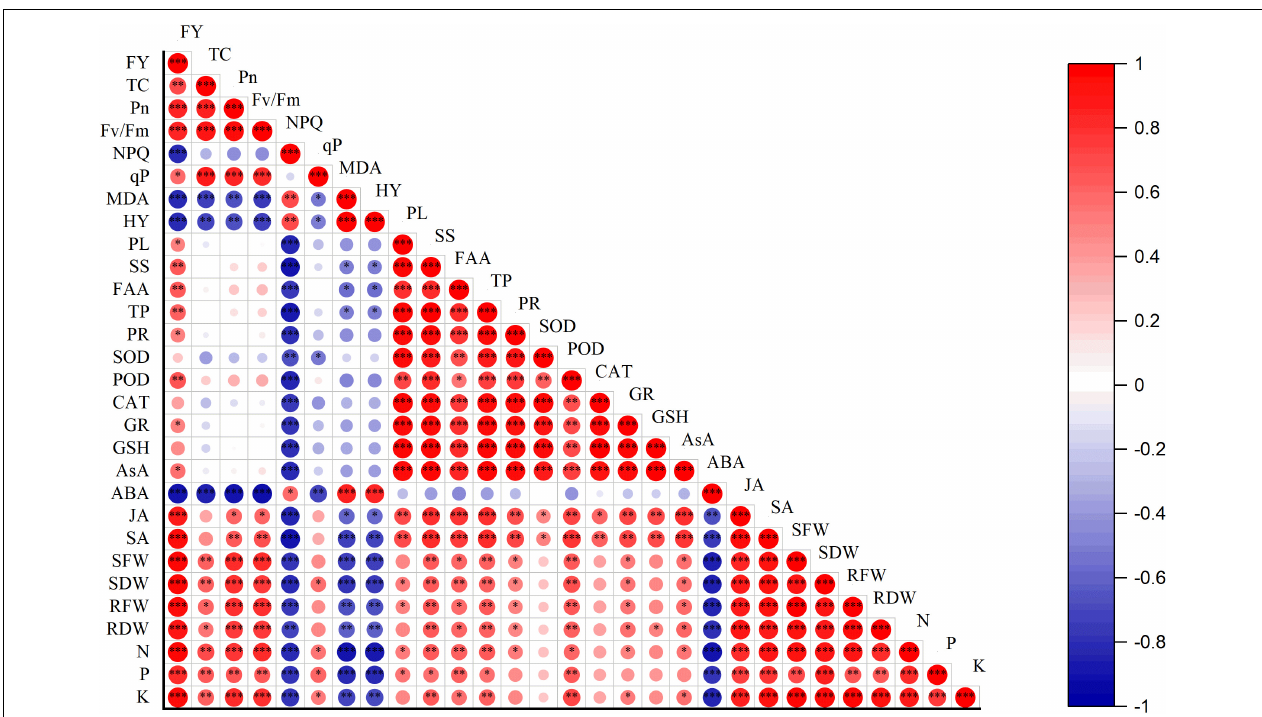
FIGURE 9 | Correlation between growth, physiological, biochemical traits, and eggplant yield. Pearson correlation between eggplant growth, physiological, biochemical, and yield-related parameters. The red color represents a positive correlation, while the blue color means a negative correlation. The lighter colors and small circles indicate the lower values of the correlation coefficient, whereas darker colors and bigger circles show a high positive correlation. FY, fruit yield; TC, total chlorophyll; Pn, photosynthesis; F v / F m , maximal photochemical efficiency; NPQ, non-photochemical quenching coefficient; qP, photochemical quenching; MDA, malonaldehyde; H 2 O 2 , hydrogen peroxide; PL, proline; SS, soluble sugar; FAA, free amino acid; TP, total phenols; SOD, POD, CAT, GR, GSH, AsA, superoxide dismutase, peroxidase, catalase, glutathione reductase, reduced glutathione, ascorbic acid, respectively. ABA, JA, SA, abscisic acid, jasmonic acid, salicylic acid, respectively. SFW, shoot fresh weight; SDW, shoot dry weight; RFW, root fresh weight; RDW, root dry weight; N, P, K, mineral nutrients. The stars indicate a significant correlation at ( ∗ ) 0.05, ( ∗∗ ) 0.01, ( ∗∗∗ ), and 0.001 levels of